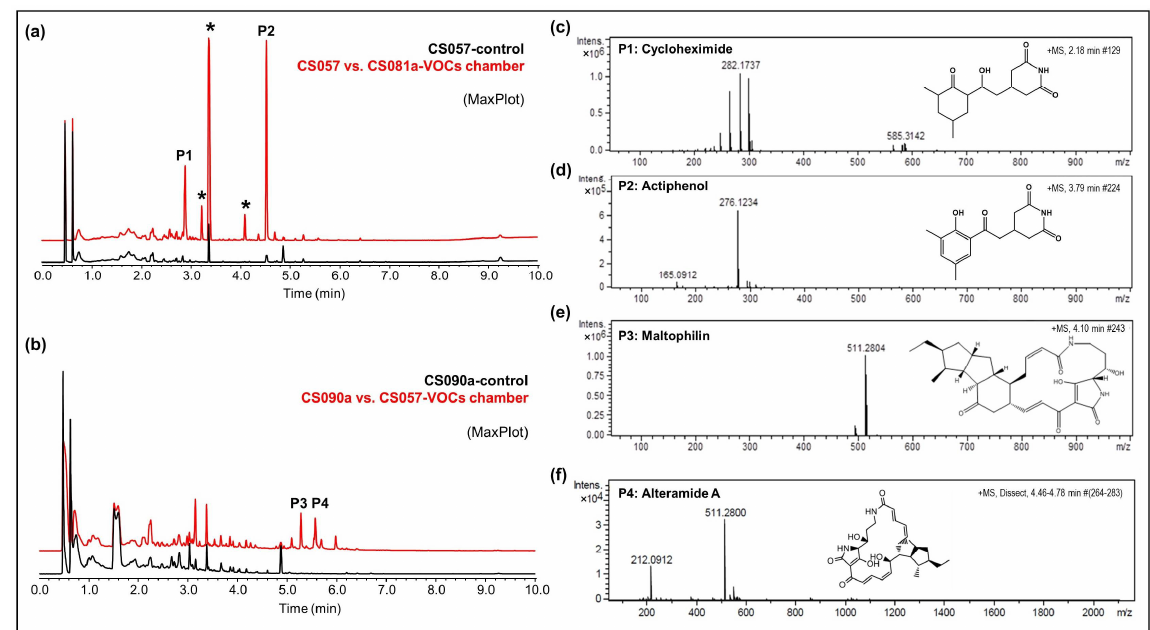
Figure 4. Activation of secondary metabolism in CS057 and CS090a strains. ( a ) Comparative UPLC analysis of samples of CS057 (control plate, black) and CS057 exposed to VOCs produced by CS081a (red). Asterisks indicate intermediates of actiphenol biosynthesis; cycloheximide (P1); actiphenol (P2). ( b ) Comparative UPLC analysis of samples of CS090a (control plate, black) and CS090a exposed to VOCs produced by CS057 (red). Maltophilin (P3) and alteramide A (P4); ( c ) HRMS spectrum of cycloheximide, ( d ) HRMS spectrum of actiphenol, ( e ) HRMS spectrum of maltophilin; ( f ) HRMS spectrum of alteramide A.